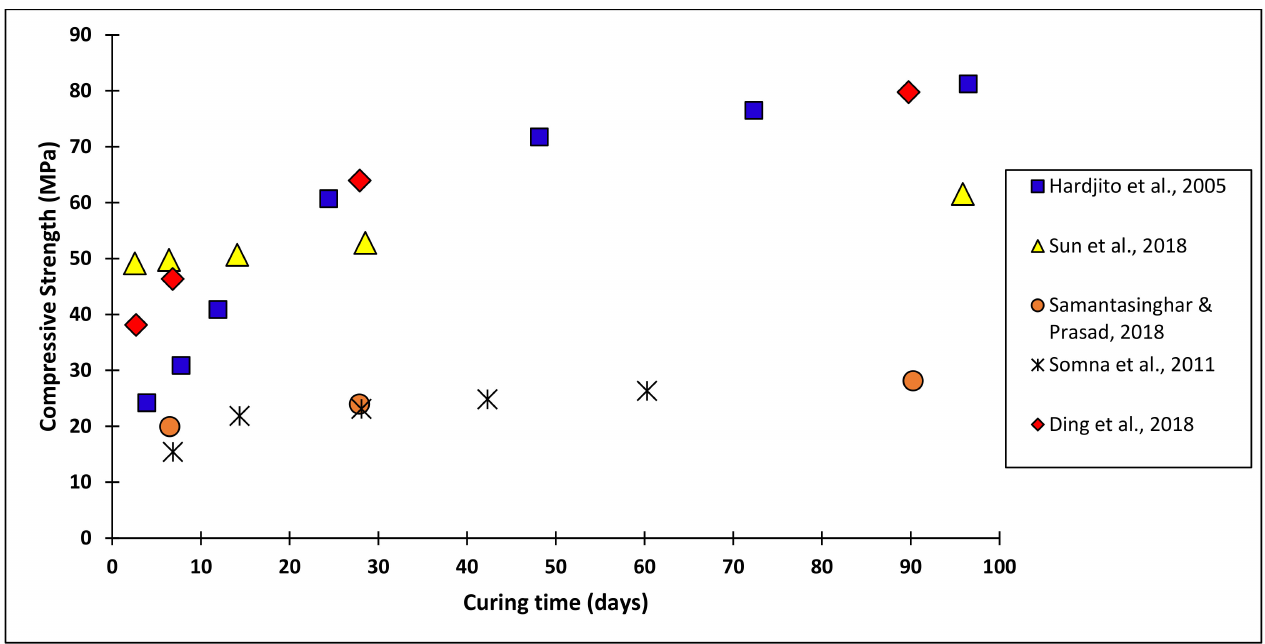
Figure 4. Graph compiling compressive strength versus curing time data obtained in previous investigations [54,92,97,101,161].